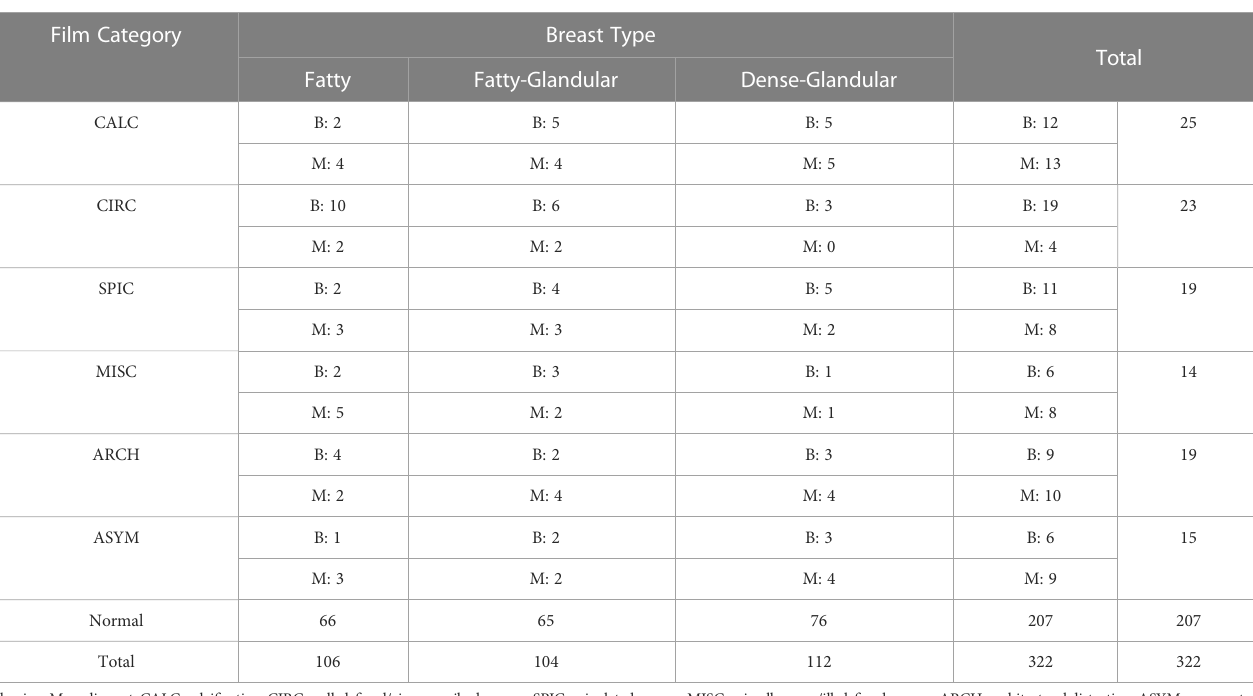
TABLE 2 Summary of the contents of